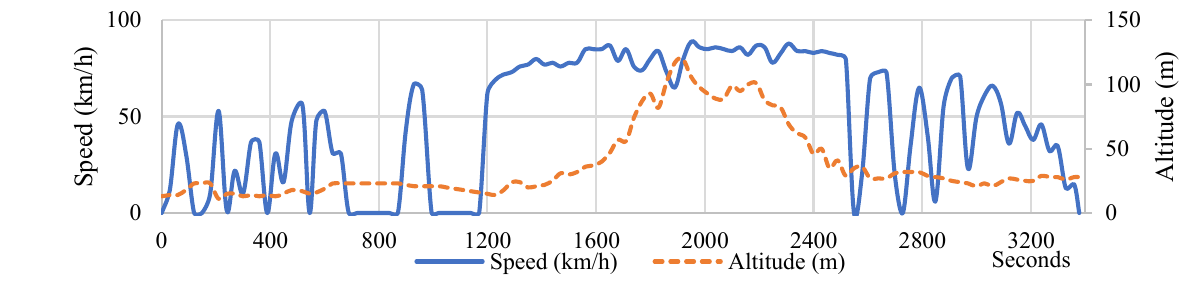
Figure 3. Drive cycle 2: GCM of 50,000 kg.